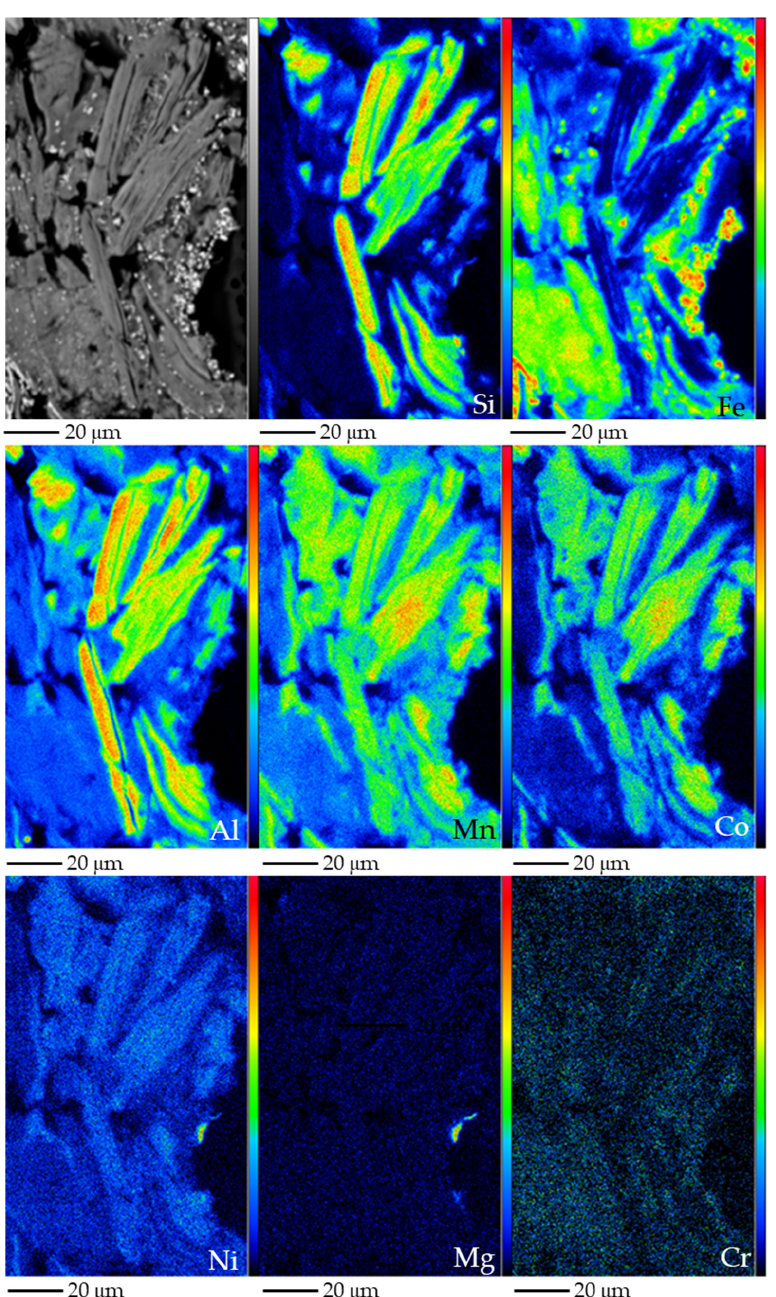
Figure 12. BSE photomicrograph of sample LHA (top left), and Si, Fe, Al, Mn, Co, Ni, Mg and Cr X-ray elemental maps obtained by EMPA, of an aggregate of Mn–Ni–Co-bearing chlorite. Colour scale from black to red indicates increasing element content.